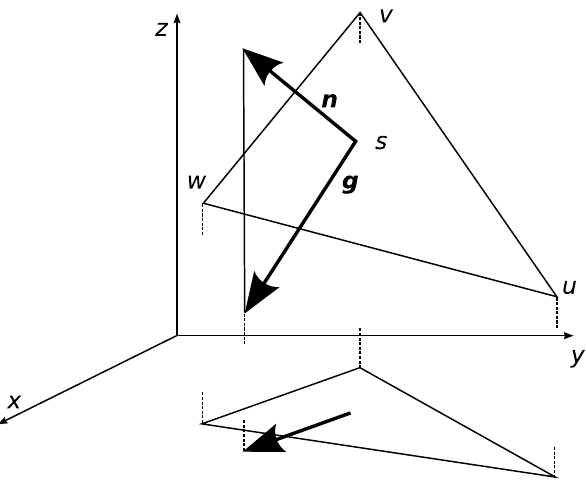
Fig. 1. Derivation of the slope gradient for a single triangle. The horizontal projection of the triangle is added to the sketch for illus- tration.